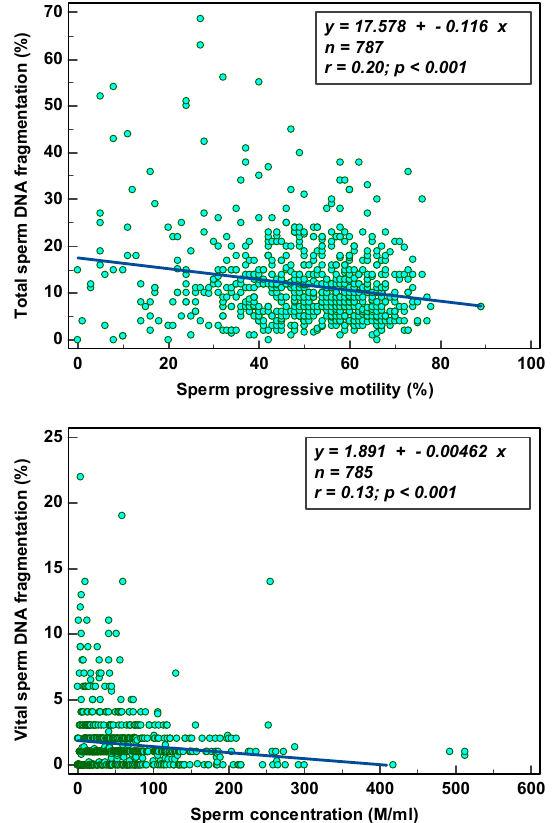
Figure 3. Scatter diagram with regression line between SDF parameters and semen parameters. Total SDF did not differ significantly ( p = 0.416) whether the semen samples were from an F (8.1 ± 5.8; n = 42), SN (11.7 ± 7.8; n = 416) or SN-N (12.2 ± 10.2; n = 295) study group. The same was also the case ( p = 0.688) in the vital SDF fractions (F = 1.3 ± 1.4; SN = 1.4 ± 1.6 and SN-N = 2.0 ± 3.0, respectively). Figure 4 reveals the distribution of SDF parameters in the three study groups.